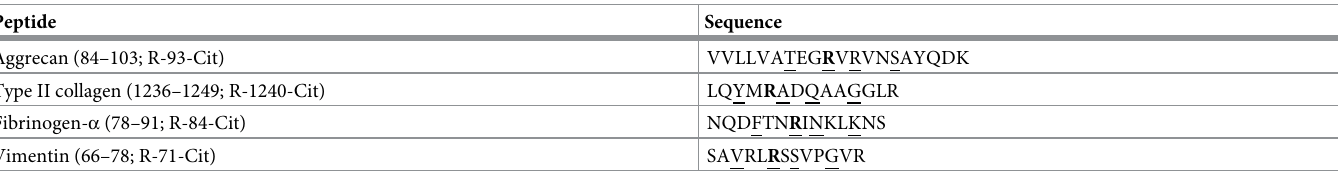
Table 1. Sequences of peptides tested for their ability to bind to HLA-DR1 and DR4 and to induce a CD4+ T cell response in mice expressing these HLA-DR allotypes. Peptide